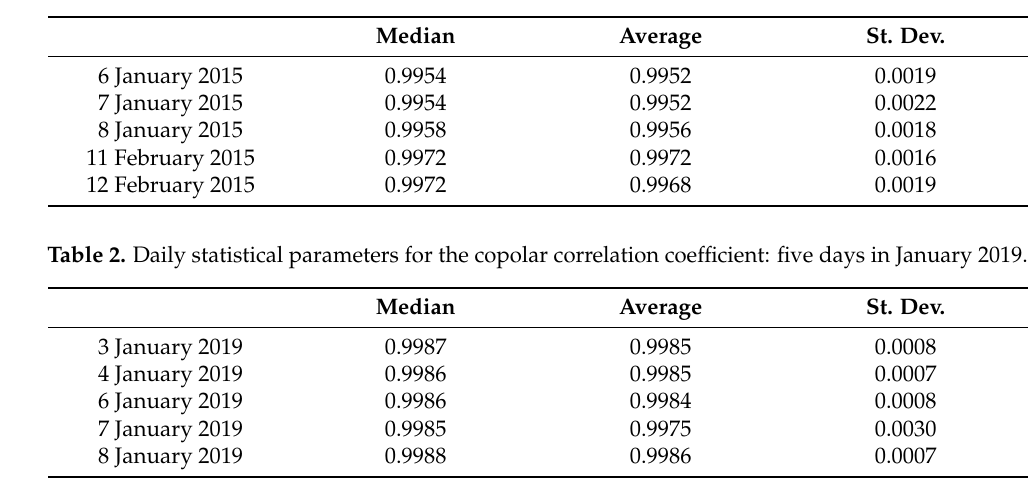
Table 1. Daily statistical parameters for the copolar correlation coefficient: five days in winter 2015.